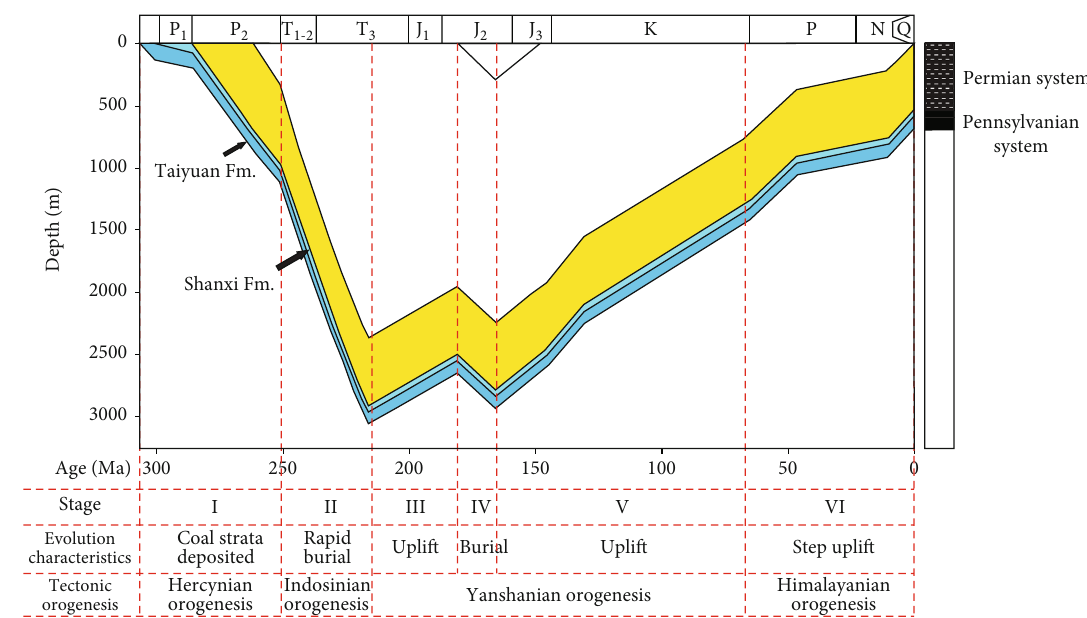
Figure 5: Typical tectonic movement and burial history curve for the coal-bearing strata in the study